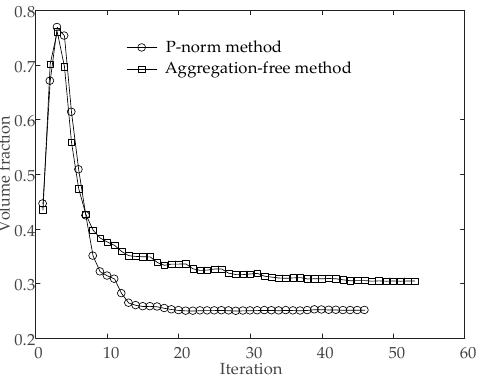
Figure 6. Convergent history of the objective function for an L-bracket subjected to a single load.